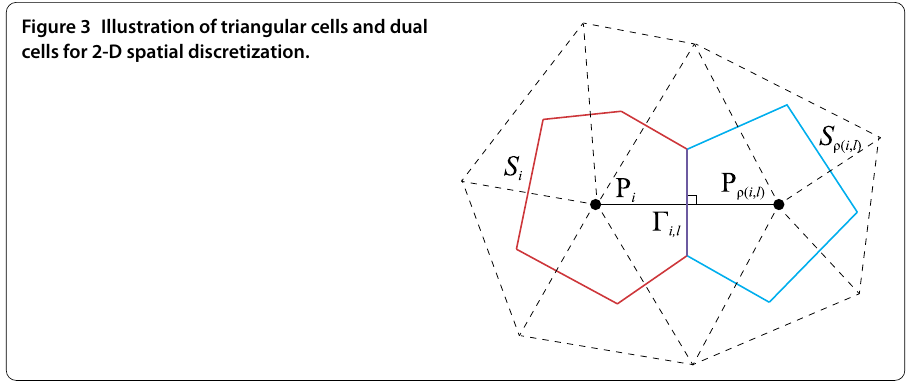
Figure 3 Illustration of triangular cells and dual cells for 2-D spatial